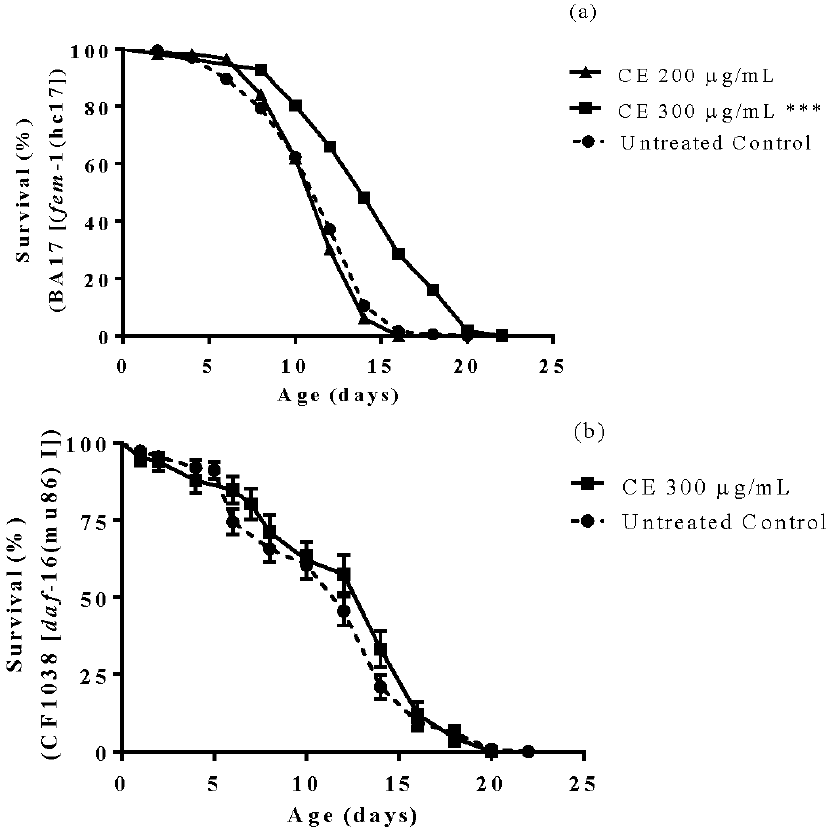
Figure 5. Longevity of nematodes after treatment with C. spruceanum extract (CE). Worms (BA17) treated with CE 300 µ g/mL lived significantly longer compared to control group ( a ). Worms CF1038 treated with CE or untreated exhibited the same lifespan ( b ). The results are presented as percentage of survival and the statistical significance determined by Log-rank (Mantel-Cox) tests followed by Gehan-Breslow-Wilcoxon Test. *** p < 0.0001. as compared to the untreated control by one-way ANOVA followed by Bonferroni